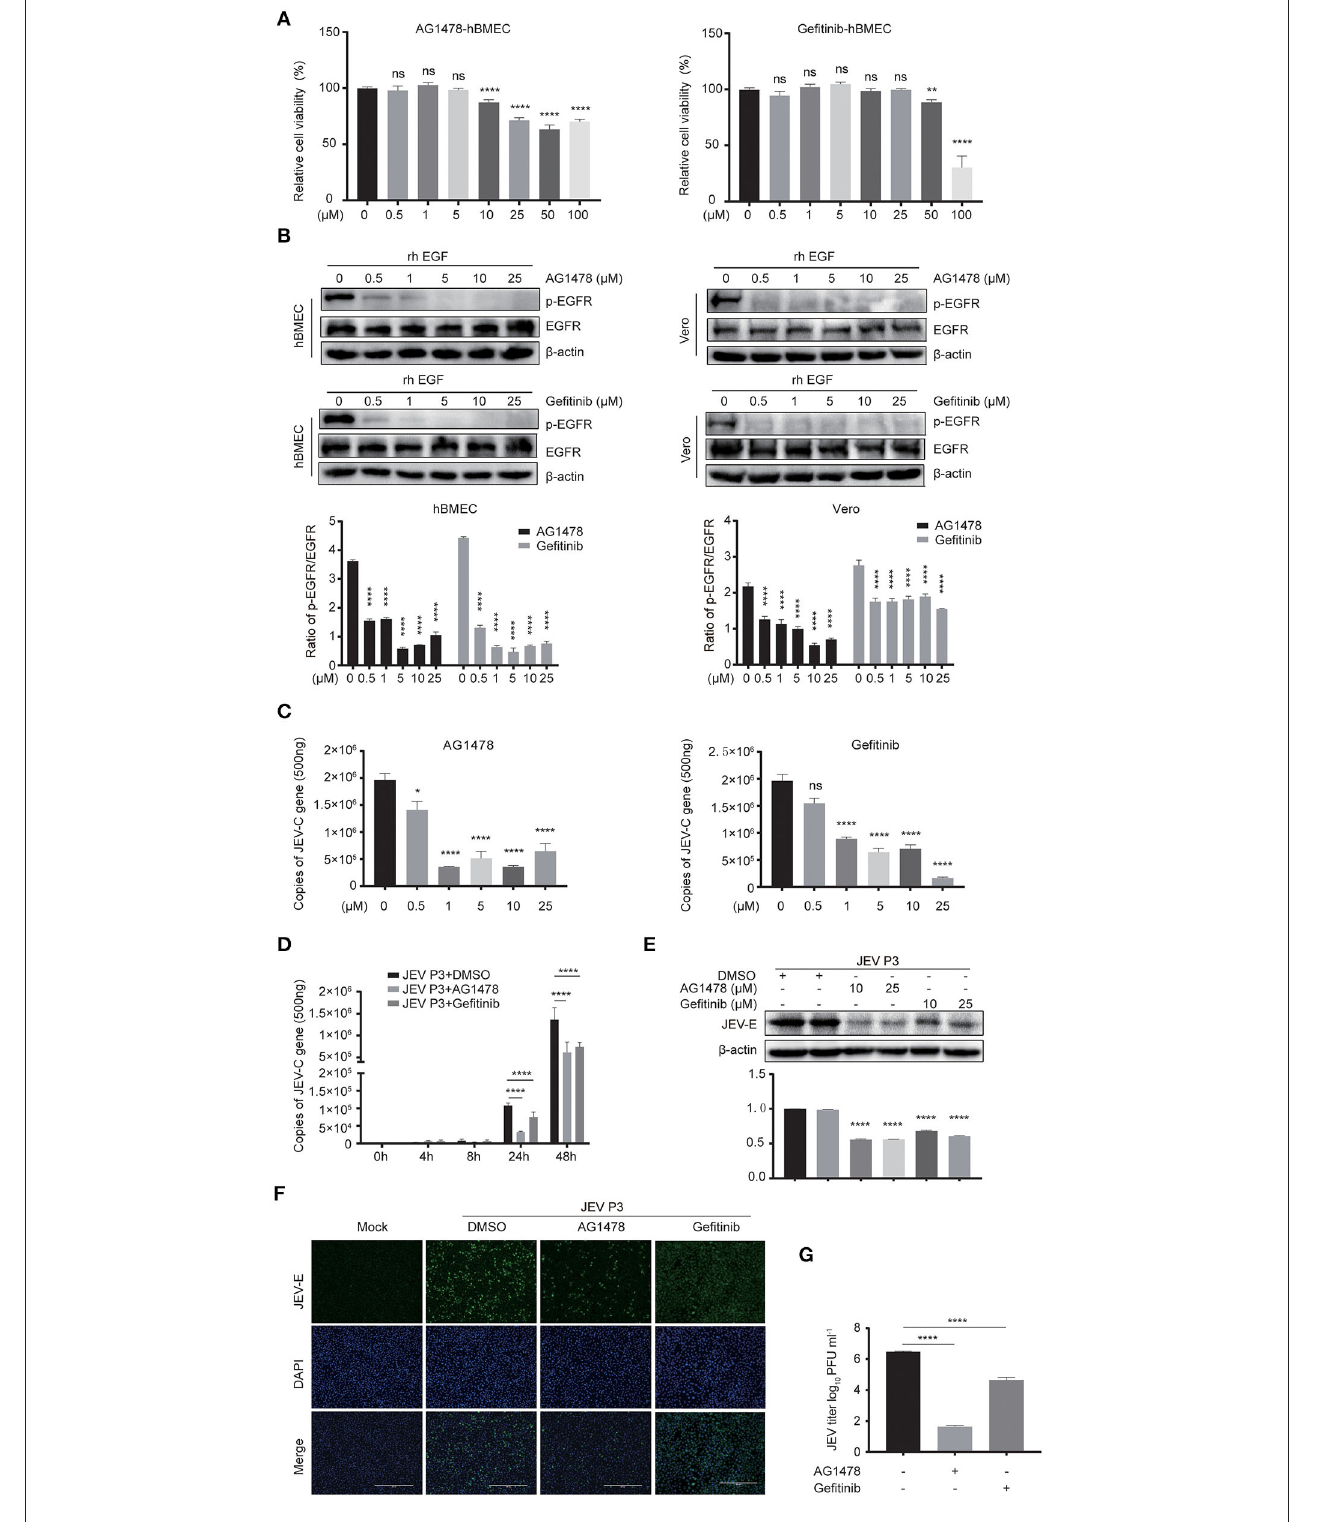
FIGURE 3 | EGFR inhibitors reduce JEV infection in hBMECs. (A) Cell cytotoxicity of the EGFR inhibitors. hBMECs were treated with the carrier control DMSO, AG1478, or gefitinib at various concentrations for 48h, and cell cytotoxicity was analyzed with the CCK-8 assay. (B) The inhibitory effect of AG1478 and gefitinib in rhEGF-treated cells. The hBMECs and Vero cells were treated with corresponding concentrations of AG1478 and gefitinib for 2h and then rhEGF was added for